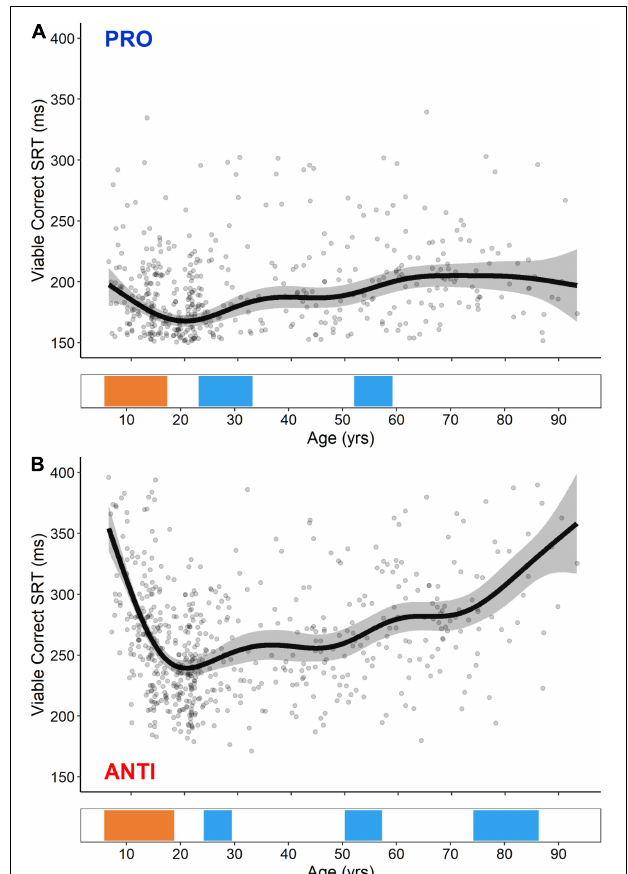
FIGURE 3 | GAM fits and significant periods of change for PRO (A) and ANTI (B) viable correct SRT. Scatter points are individual participants, black curves are the GAM fits, and gray ribbons are the 95% confidence intervals. Bottom tiles indicate significant periods of developmental-related (orange) and aging-related (blue)